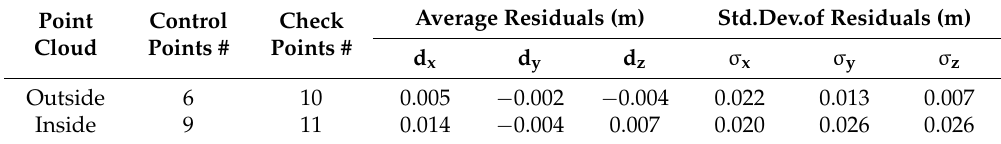
Table 1. The georeferencing results of inside and outside point cloud model of the Mevlana Museum. Point Cloud